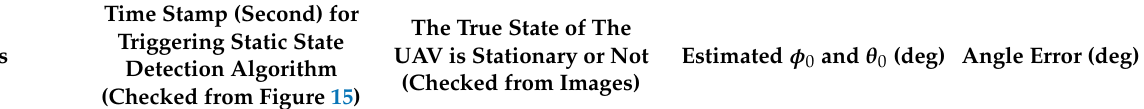
Table 5. Results of a static state detection algorithm for the EuRoC dataset.